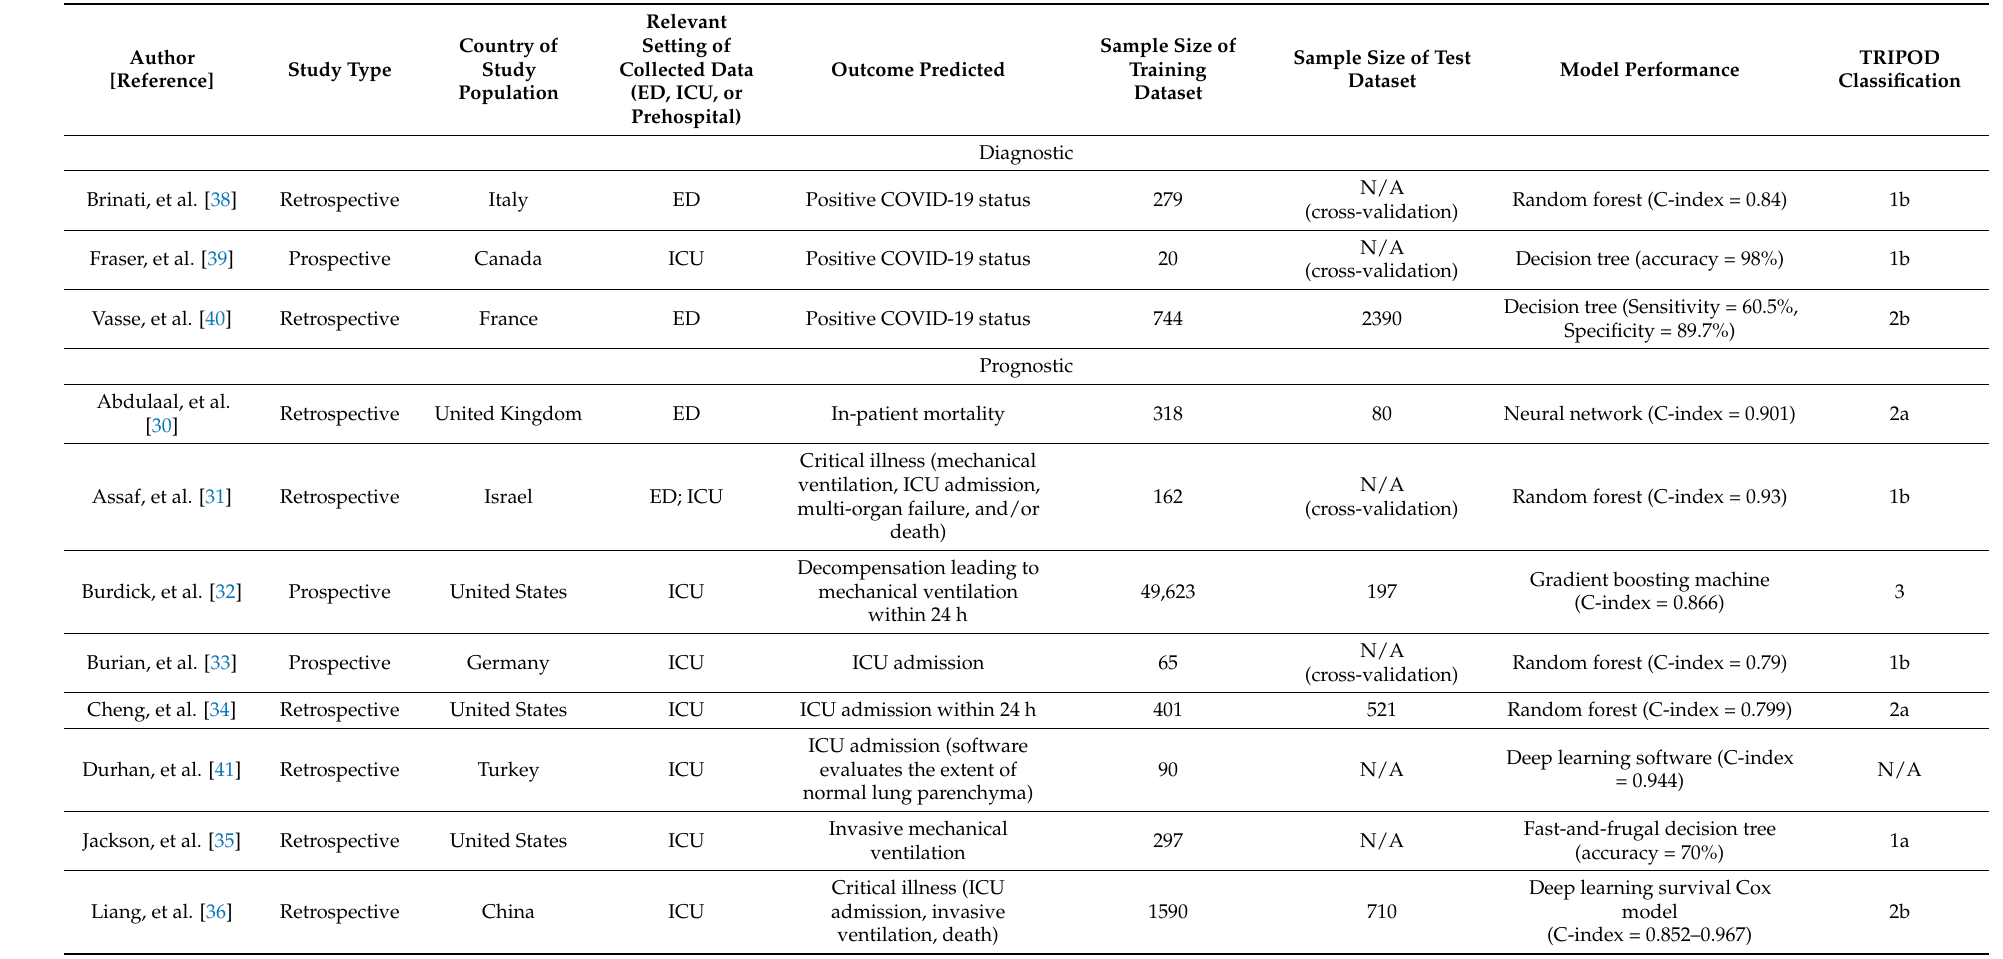
Table 1. Main study